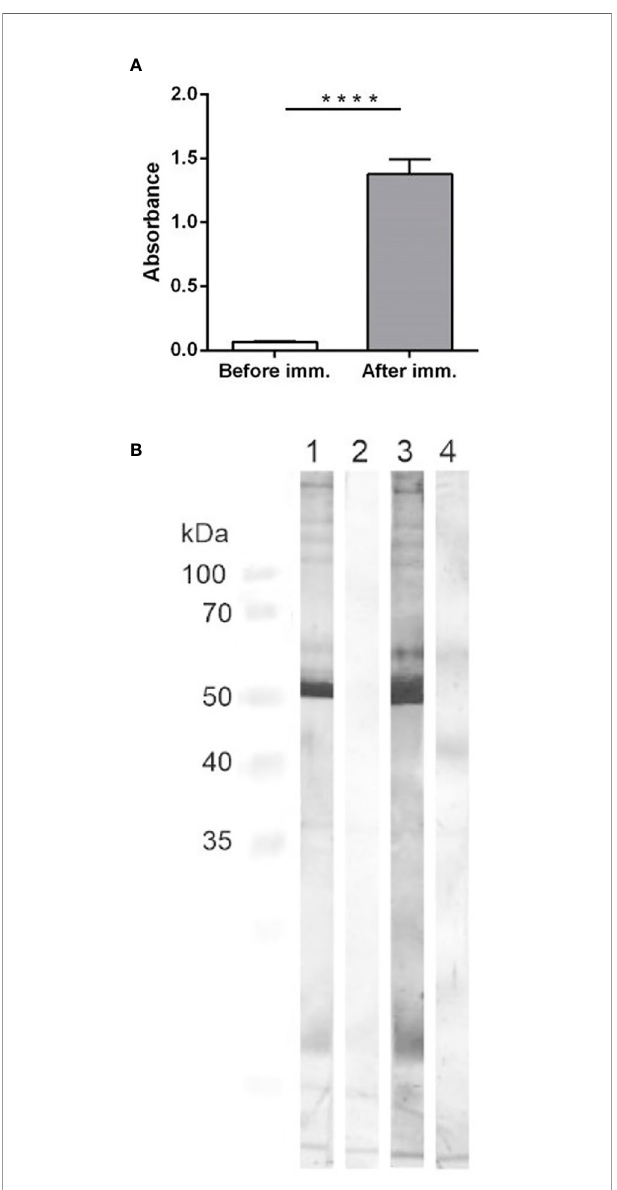
FIGURE 2 | (A) : ELISA detection of speci fi c antibodies against the crude capsular extract. The graph shows the antibody titer of antibodies in sera from pigs before the immunization and at 14 days after the second immunization with the cCE. Signi fi cant difference between the groups is denoted by asterisks (p<0.0001). (B) : Western-blotting. Antigen – the crude capsular extract. Primary antibodies: 1- IgG isolated from the positive pooled serum, 2 - IgG isolated from the negative pooled serum, 3 – positive pooled serum from pigs after the second immunization, 4 – negative pooled serum from pigs before the immunization. Secondary antibodies: goat anti-pig HRP- conjugated IgG. Speci fi c protein bands were visualized with 3, 3´-